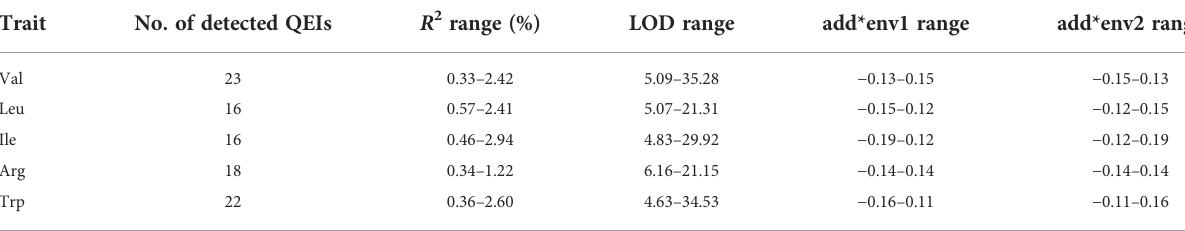
TABLE 3 QTN-by-environment interactions (QEIs) detected from fi ve FAA content datasets.